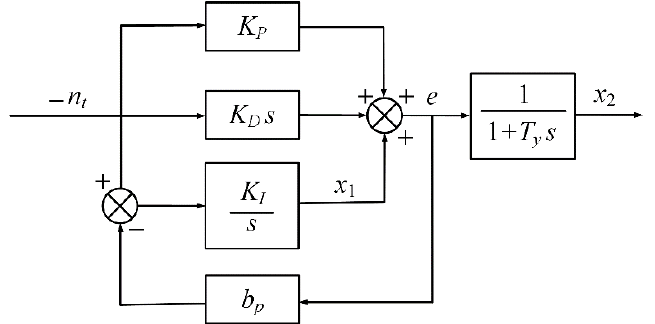
Figure 6. The schematic diagram of the PID governor.